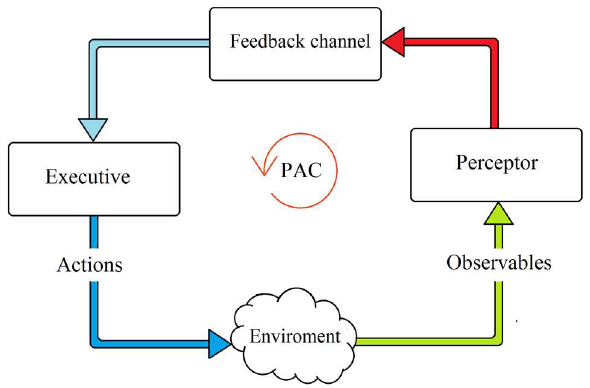
Figure 2. Block diagram of a basic cognitive dynamic system.